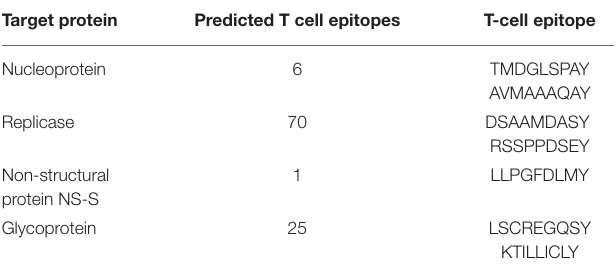
TABLE 2 | Details of total identified T-cell epitopes and shortlisted ones for the vaccine design against each target protein of RVFV.